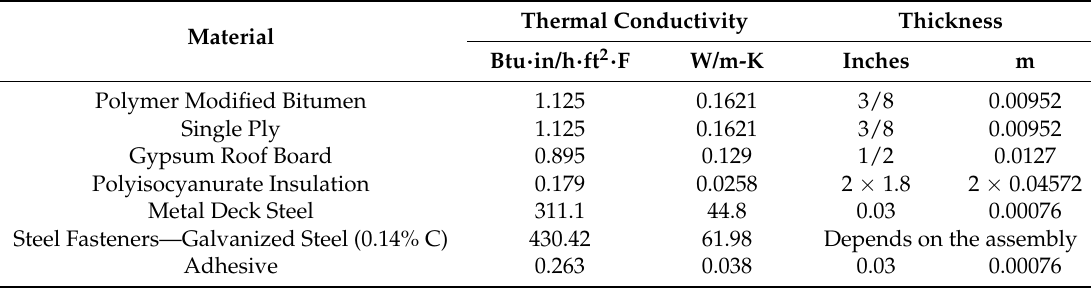
Table 2. Material Properties.